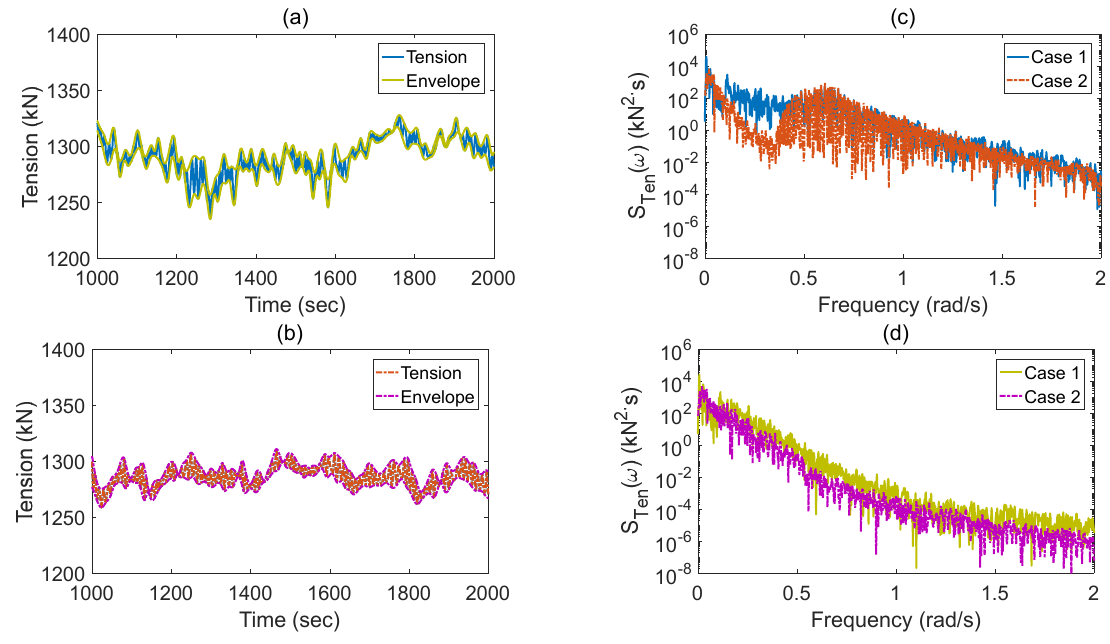
Figure 11. Time histories and power density spectra of mooring tension. ( a ) Time histories of tension under the wave group; ( b ) Time histories of tension under the stochastic wave; ( c ) The power density spectra of tension under the wave group; ( d ) The power density spectra of tension under the stochastic wave.